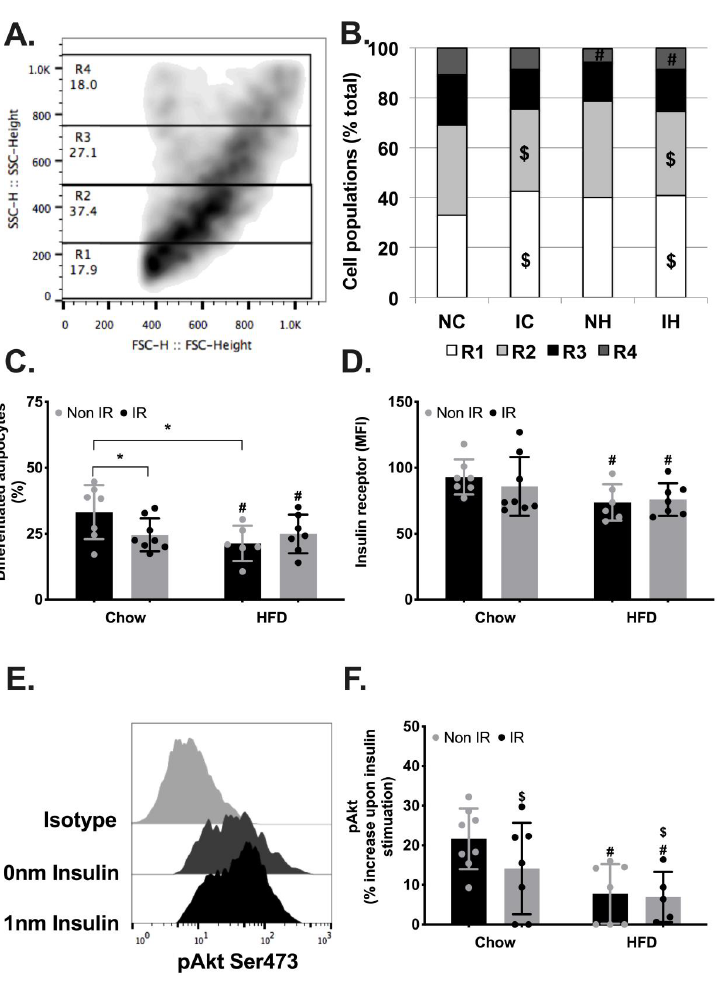
Figure 4. Adipocyte development and metabolic functions. ( A ). Representative flow cytometry analysis showing the four regions (R1-R4) defined by the granularity of the cells, indicative of their lipid accumulation at the end point of adipogenesis. ( B ). Quantification of the distribution of adipocytes across the four regions based on their differentiation (from not differentiated, R1, to highly differentiated, R4). ( C ). Proportion of highly differentiated adipocytes (contained in R3 and R4) at the end point of adipogenesis. ( D ). Expression of insulin receptor measured by flow cytometry on differen-